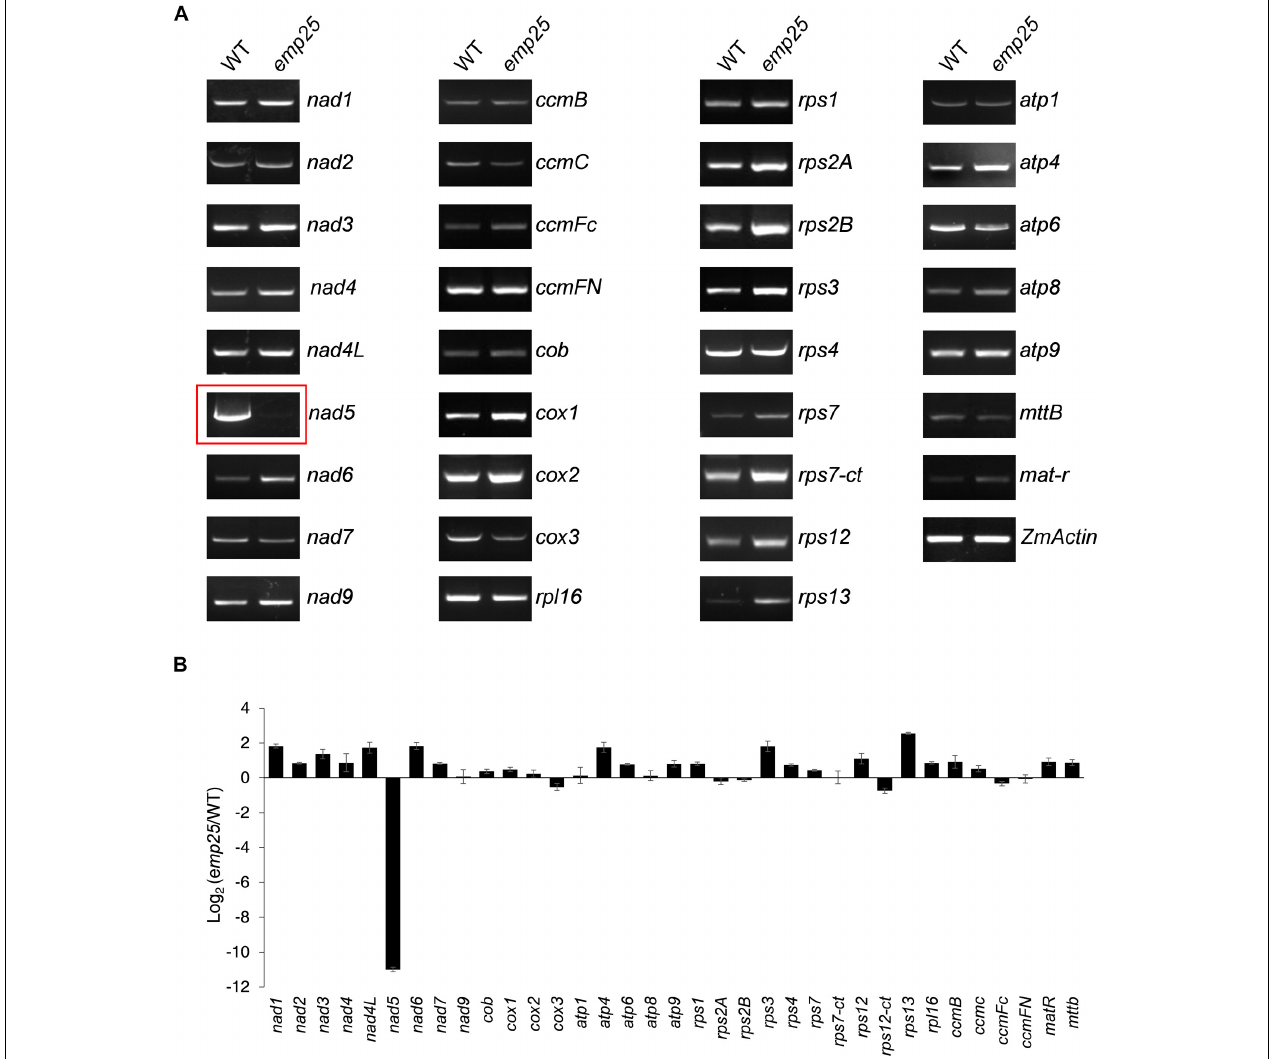
FIGURE 4 | Analysis of mitochondrial gene transcripts in the emp25 kernels. (A) RT-PCR analysis of the 34 mitochondrial protein coding genes in emp25 with corresponding WT siblings. (B) qRT-PCR analysis of the mitochondrial transcripts in WT and emp25. Values represent the mean and standard deviation of three biological replicates. RNA was extracted from 13 DAP kernels without pericarp and was normalized against ZmActin